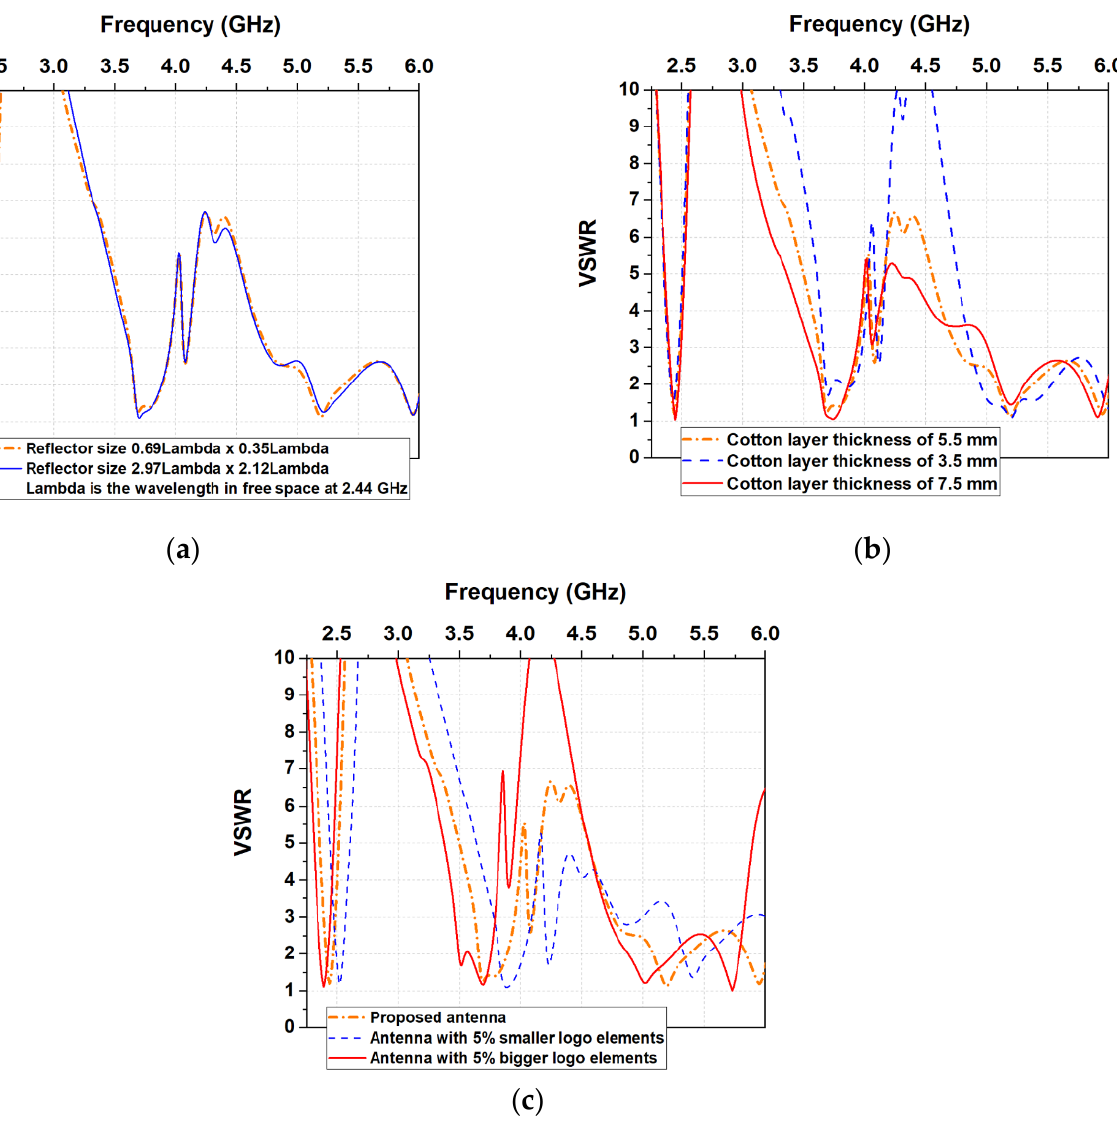
Figure 1. Configuration of the proposed antenna: ( a ) 3D view; ( b ) decomposition view; ( c ) top view with dimensions; ( d ) top view of substrate second layer with dimensions. Dimensions indicated in the figure are in millimeters.